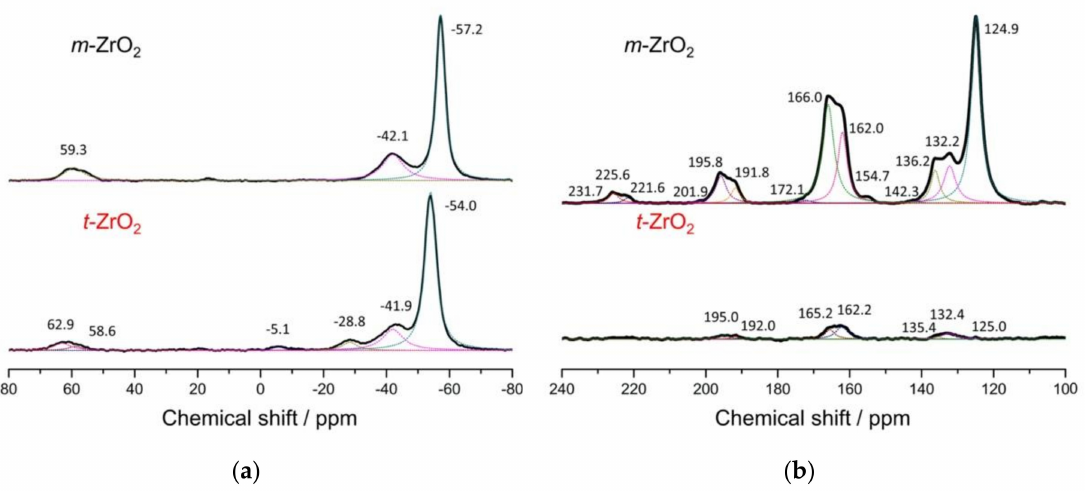
Figure 5. 31 P MAS NMR spectra of TMP absorbed on ZrO 2 samples ( a ) and 13 C MAS NMR spectra of 13 CO 2 absorbed on ZrO 2 samples ( b